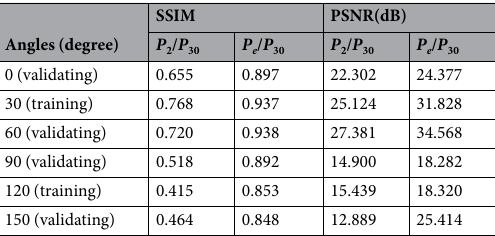
Table 1. Comparisons of the 2 s projections and the CNN enhanced projections with 30 s